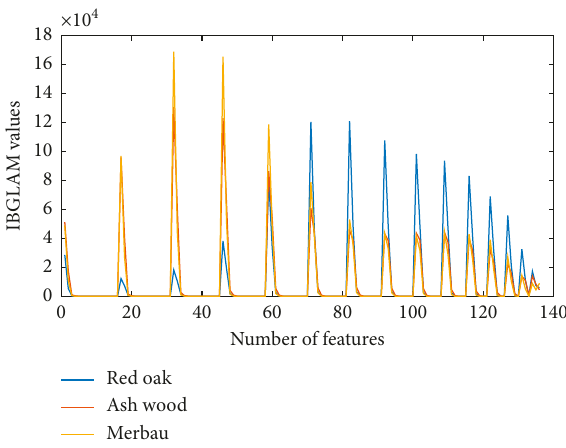
Figure 20: IBGLAM feature vector.